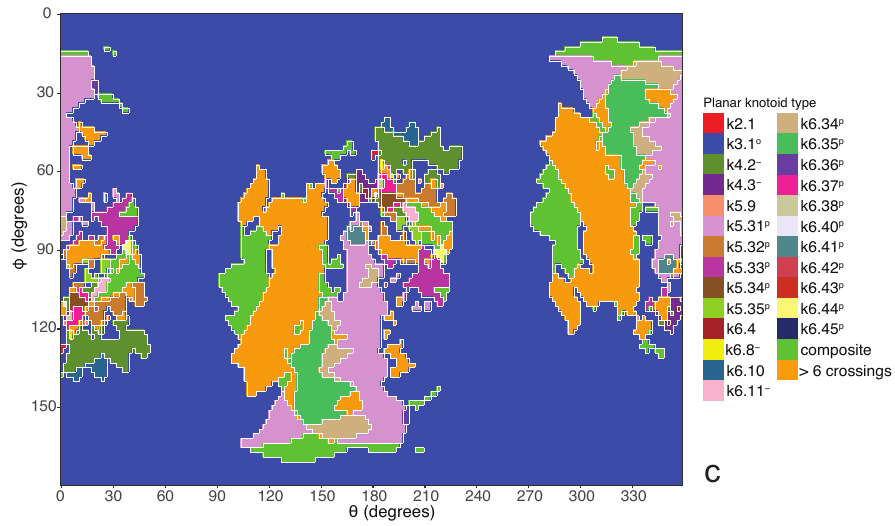
Figure 5. The projection maps for ( a ) the uniform closure technique; ( b ) the spherical knotoids technique; and ( c ) the planar knotoids